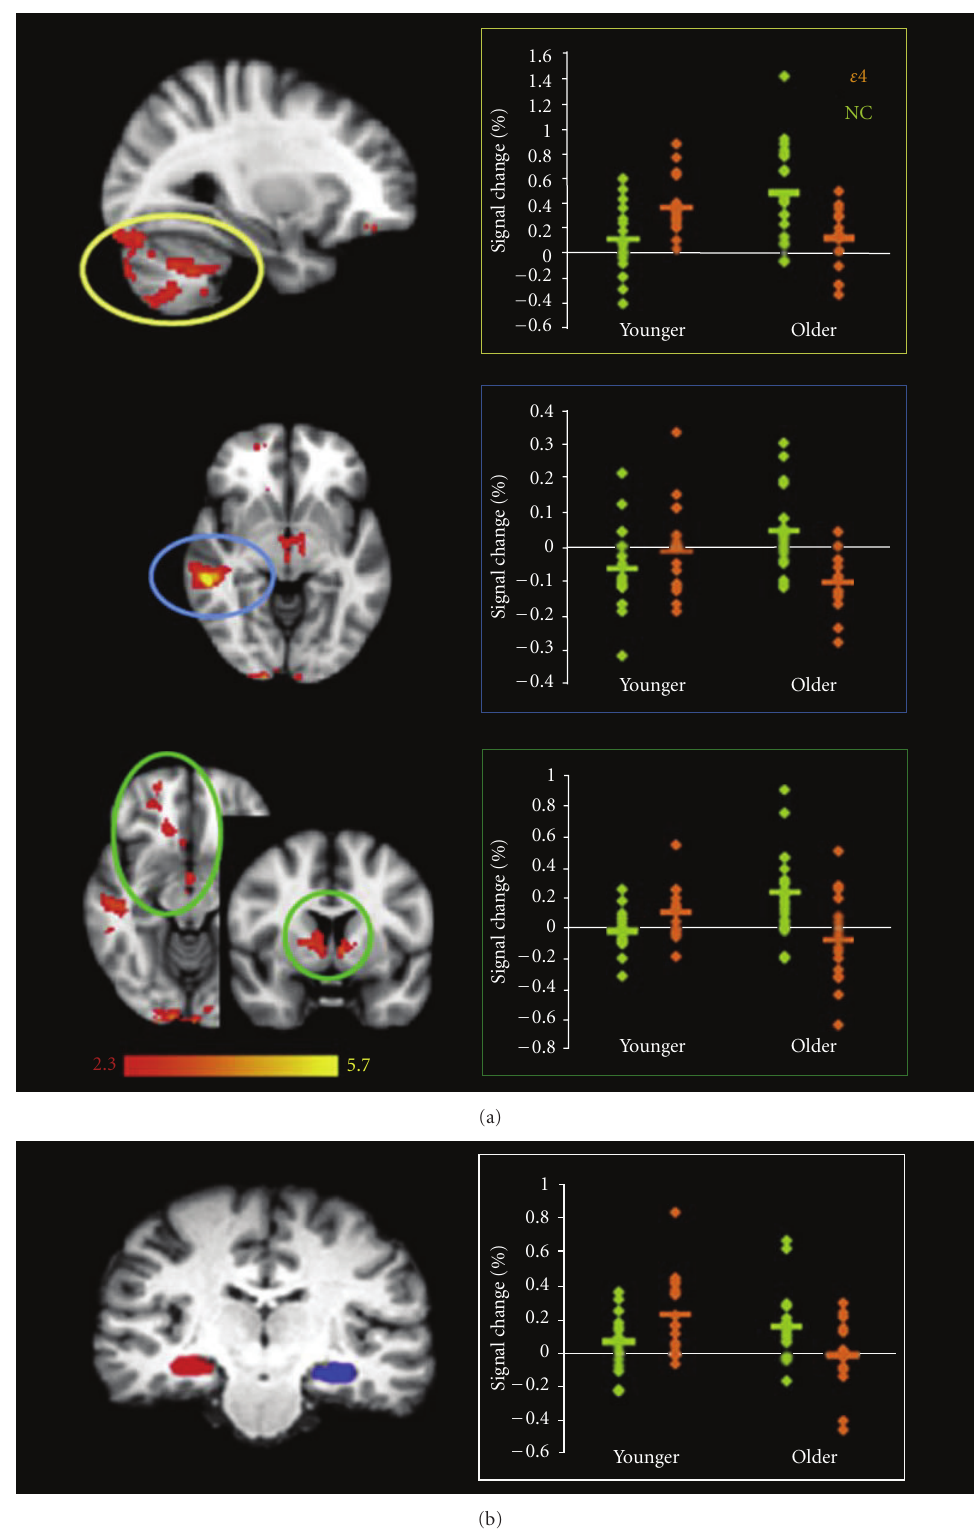
Figure 6: AGE by GENE interactions in the “novel versus familiar” contrast of the encoding task. (a) Regions showing significant interaction between AGE and GENE factors ( P < 0 . 05, corrected for multiple comparisons) with plots of percentage signal change in brain regions showing group-related di ff erences where ε 4 (orange) defines ε 4-carriers and NC (green) defines noncarriers. (b) ROIs for the left and right hippocampi overlaid on a structural image (left) with associated plot of average hippocampal percentage signal change showing significant age-by-gene interaction (left hippocampus: P = 0 . 002, right hippocampus: P = 0 . 003) (adapted with permission from